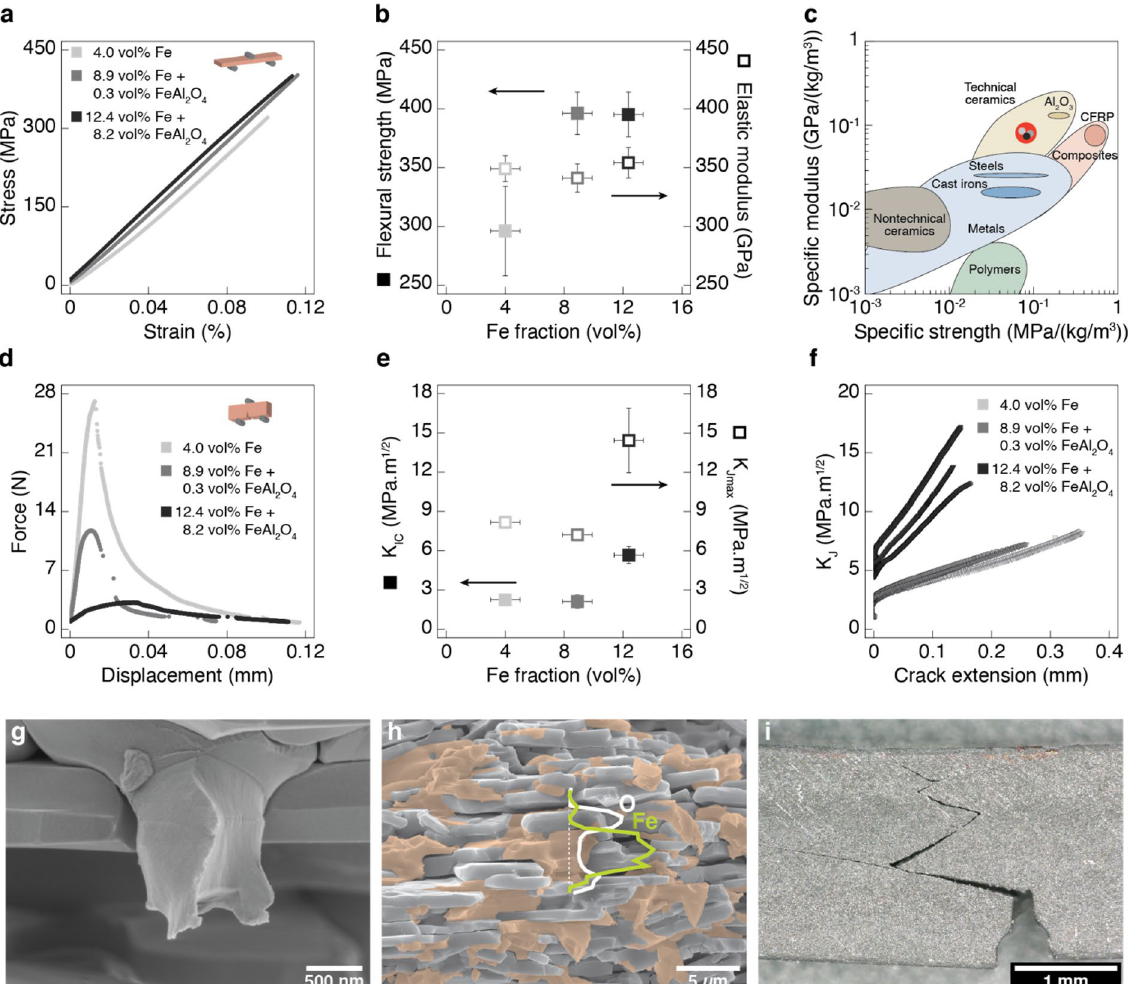
Figure 4. Mechanical properties of metal-ceramic composites with nacre-like architecture. ( a ) Stress–strain curves obtained from three-point bending tests on un-notched specimens containing different iron fractions. ( b ) Effect of the metal fraction on the flexural strength and the elastic modulus of nacre-like composites. ( c ) Ashby plot depicting the specific elastic modulus and specific strength of our metal-ceramic composites in comparison to literature data for conventional materials. ( d ) Force–displacement data obtained for single-edge notched beam samples with varying iron content. ( f ) Effect of the metal fraction on the critical stress intensity factor for crack initiation ( K IC ) and the maximum intensity factor after crack propagation ( K Jmax ). ( e ) Stress intensity factor ( K J ) of the composite as a function of the propagated crack length (R-curve). ( g , h ) Scanning electron microscopy (SEM) images of the fracture surface of a specimen containing 12.4 vol% Fe highlight ( g ) the plastic deformation of the metallic phase and ( h ) the homogeneous distribution of metallic iron within the structure. Magnification: 88 k ×. In image ( h ) the EDX intensity spectra for Fe and O elements across a selected line is displayed on top of a false coloured micrograph to illustrate the distribution of metallic and ceramic phases in the structure. Magnification: 10 k ×. ( i ) Light microscopy image of the fracture generated in a notched specimen after testing. Magnification: 100